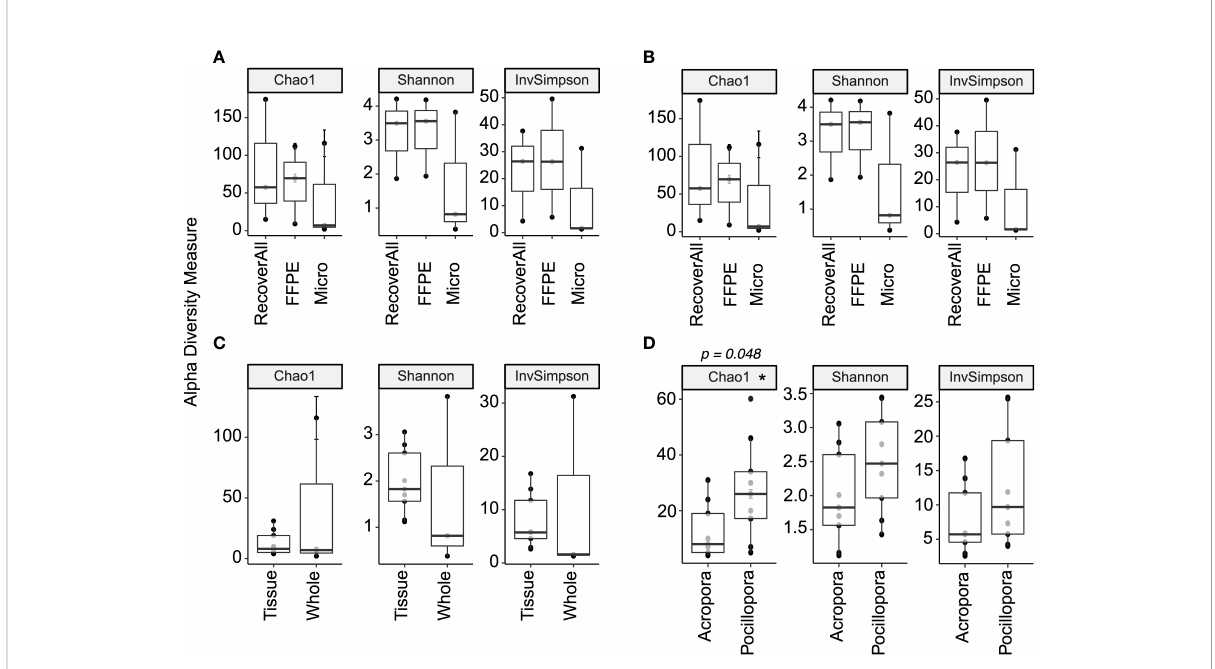
FIGURE 3 Alpha diversity metrics comparing extraction protocols between (A) whole Pocillopora samples and (B) whole Acropora samples, (C) sample type for Acropora using the Micro protocol, and (D) species using tissue samples extracted using the Micro protocol. A star (*) denotes signi fi cant differences (p <